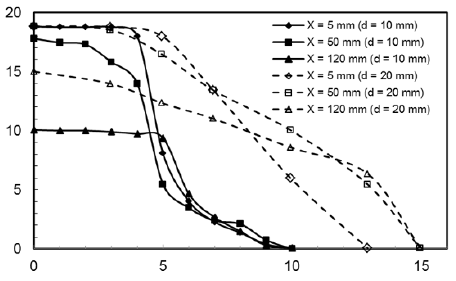
Figure 4. Radial distributions of jet velocity at different distances from the orifice for two orifice diameters, d = 10 & 20 mm (jet velocity = 20